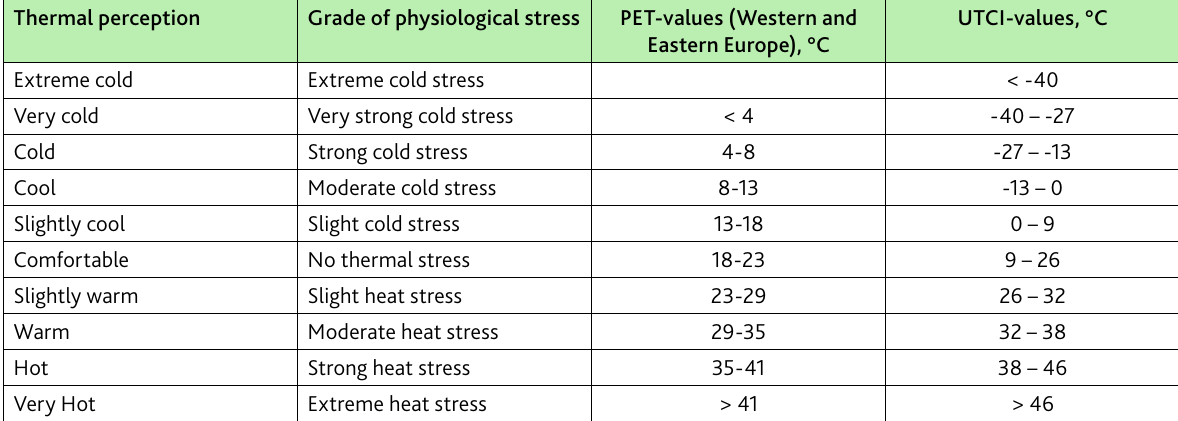
Table 1. Gradations of PET and UTCI indices (Matzarakis A.;Mayer H.,